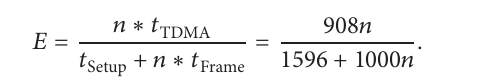
frame 𝑡 , the time of the TDMA stage in a super frame CSMA 𝑡 , and the time of the setup period 𝑡 TDMA as